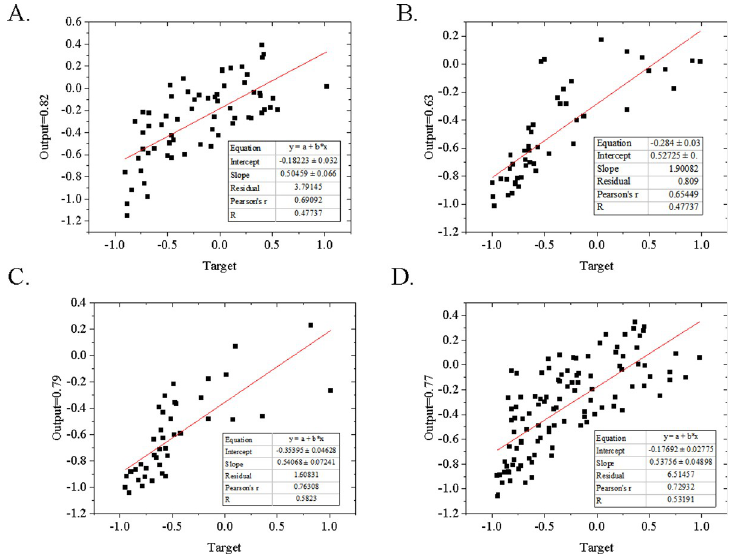
Fig 9. Regression function between network training, verification and prediction output values. Fig A: the model result under the training data set, Fig B: the model result under the verification data set, Fig C: the model result under the test data set, and Fig D: the sum test result of all